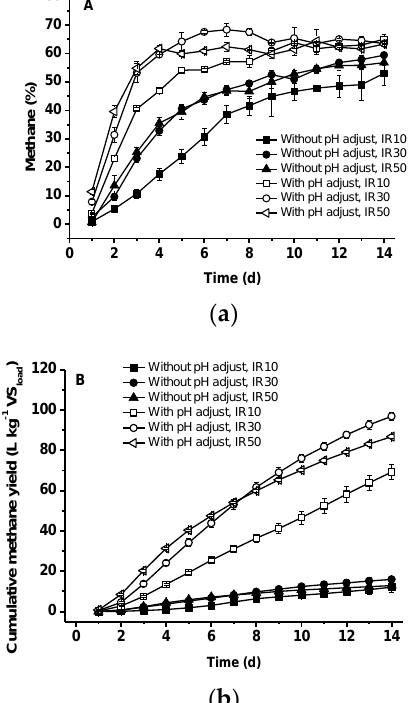
Figure 8. Effect of pH adjustment and different IR on the methane concentration ( a ) and cumulative methane yield ( b ). Data indicate mean and its standard deviation of triplicates.